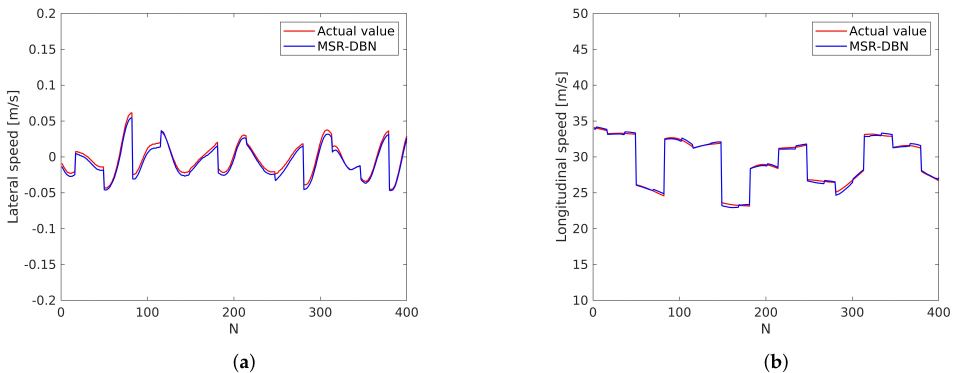
Figure 9. Prediction results on highD dataset. ( a ) Prediction result of lateral speed. ( b ) Prediction result of longitudinal